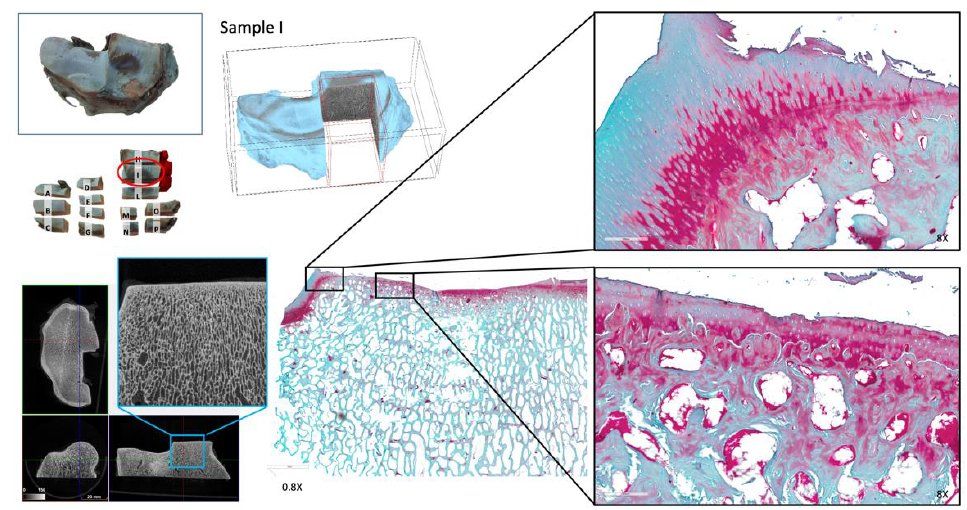
Figure 6. Histopathology specimens of the hyaline cartilage and subchondral bone of the articular surface of the radius (radio-carpal joint). The radial facet of the articular surface of the distal radius is shown. Close-up details of the histopathology of the hyaline cartilage of the radial facet are displayed. The image captured the radial facet, with extensive destructive changes to the hyaline car- tilage.